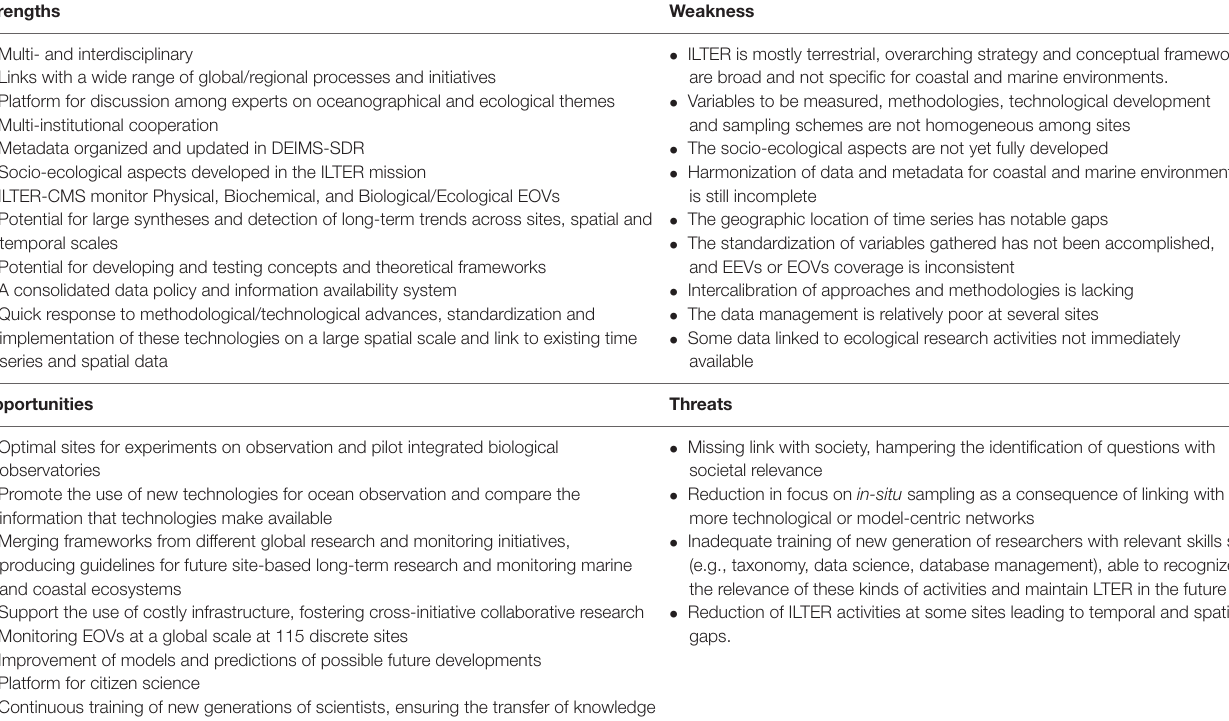
TABLE 1 | The strengths, weakness, opportunities, and threats presented by the ILTER-CMS. Strengths